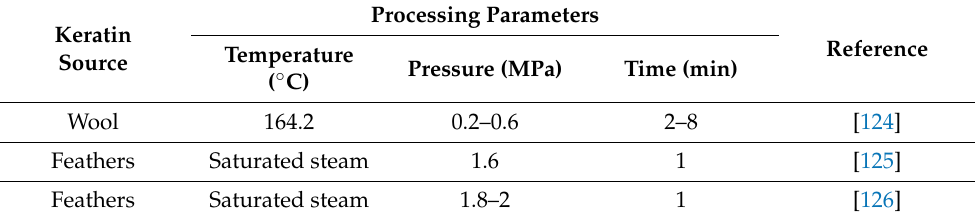
Table 8. Optimal processing parameters for keratin extraction by steam explosion method. Processing Keratin Source